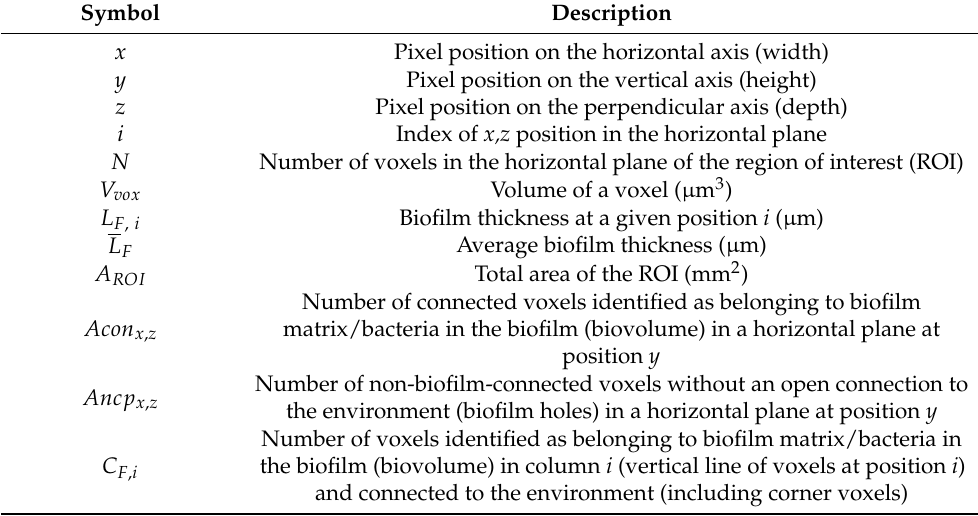
Figure 1. Two-dimensional and 3D coordinate systems for 2D and 3D OCT analyses, respectively. X represents the width, Y is the height, and Z refers to the depth. Table 1. Variable definition.